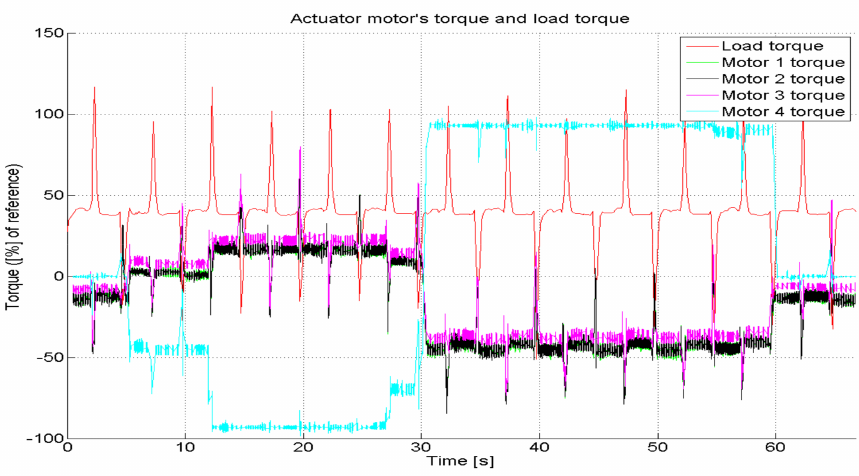
Figure 16. Torque responses in faulty operation mode.